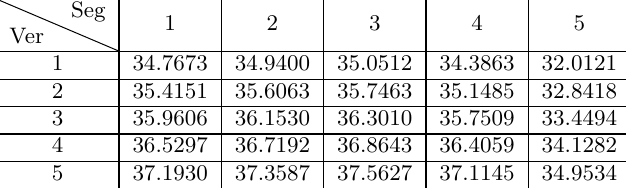
Table 3: Average PSNR for each